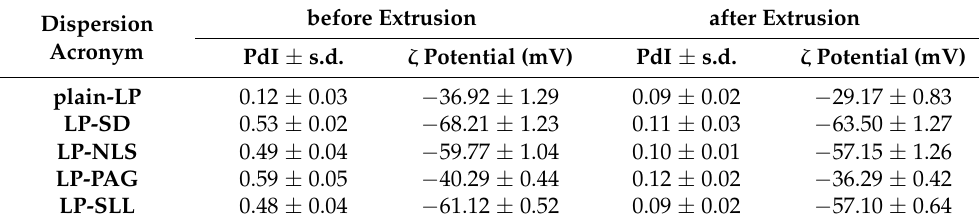
Table 2. Liposomes polidispersity index and ζ potential measured before and after extrusion.